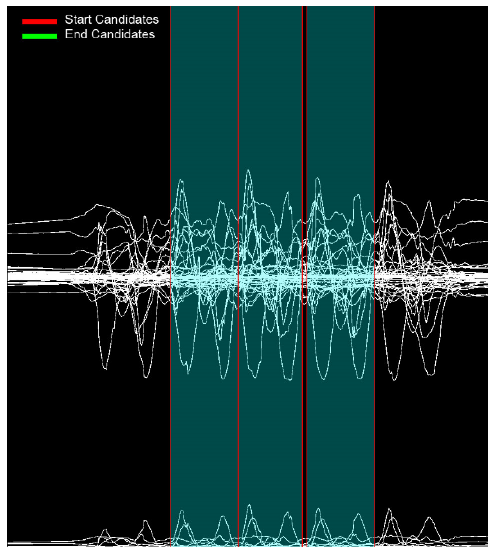
Figure 3. Reference graph. Figure 3. Target graph.